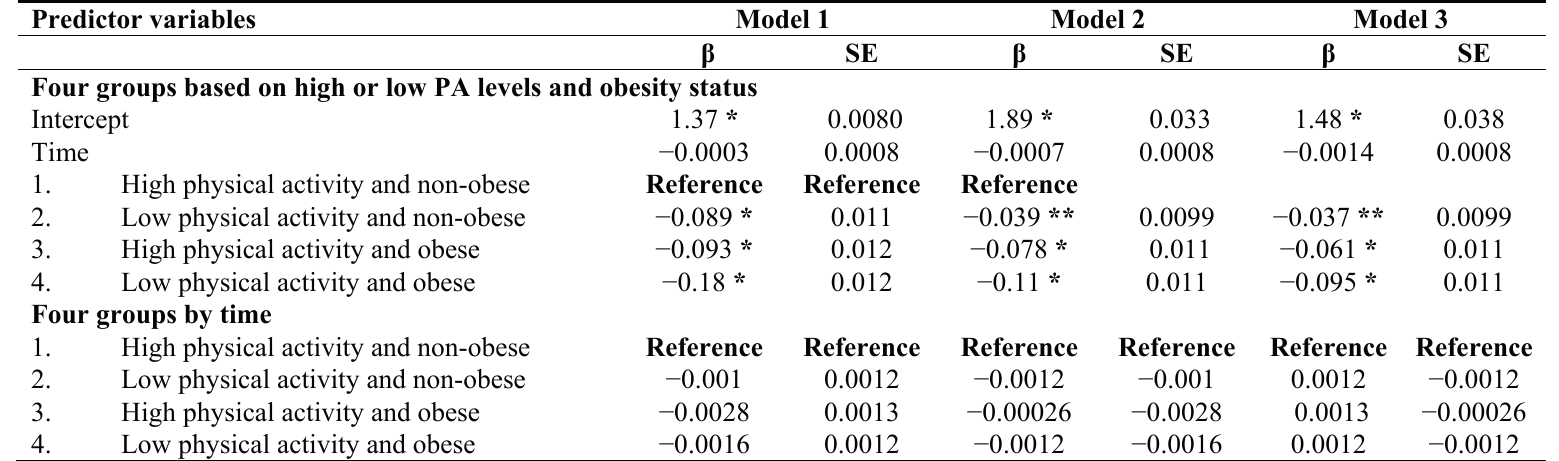
Table 3. General linear mixed models estimate for gait speed in four groups based on physical activity (PA) levels and obesity status over 6 years in older adults with frequent knee pain ( N =